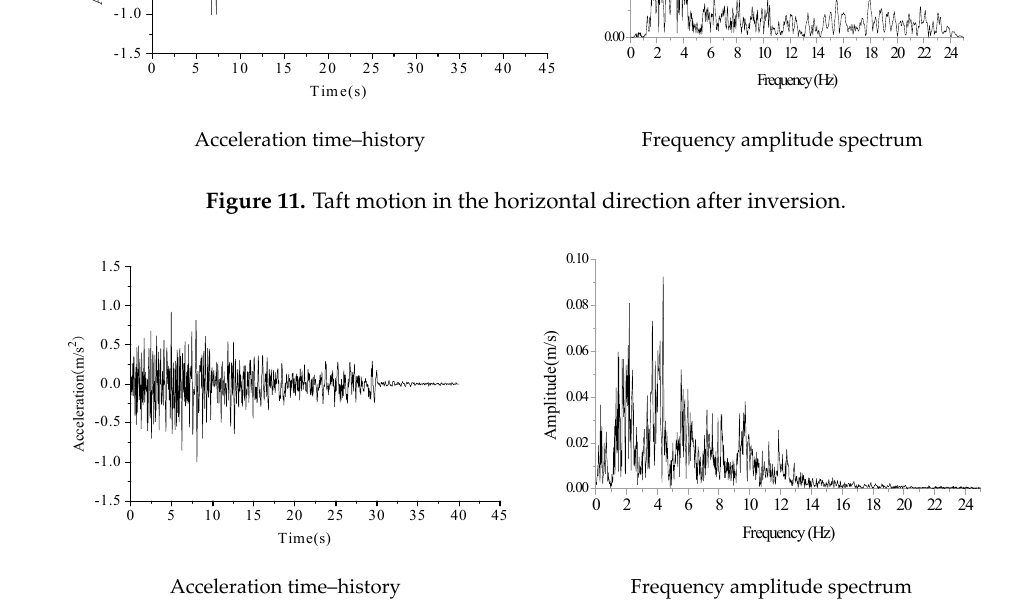
Figure 12. Taft motion in the vertical direction after inversion.